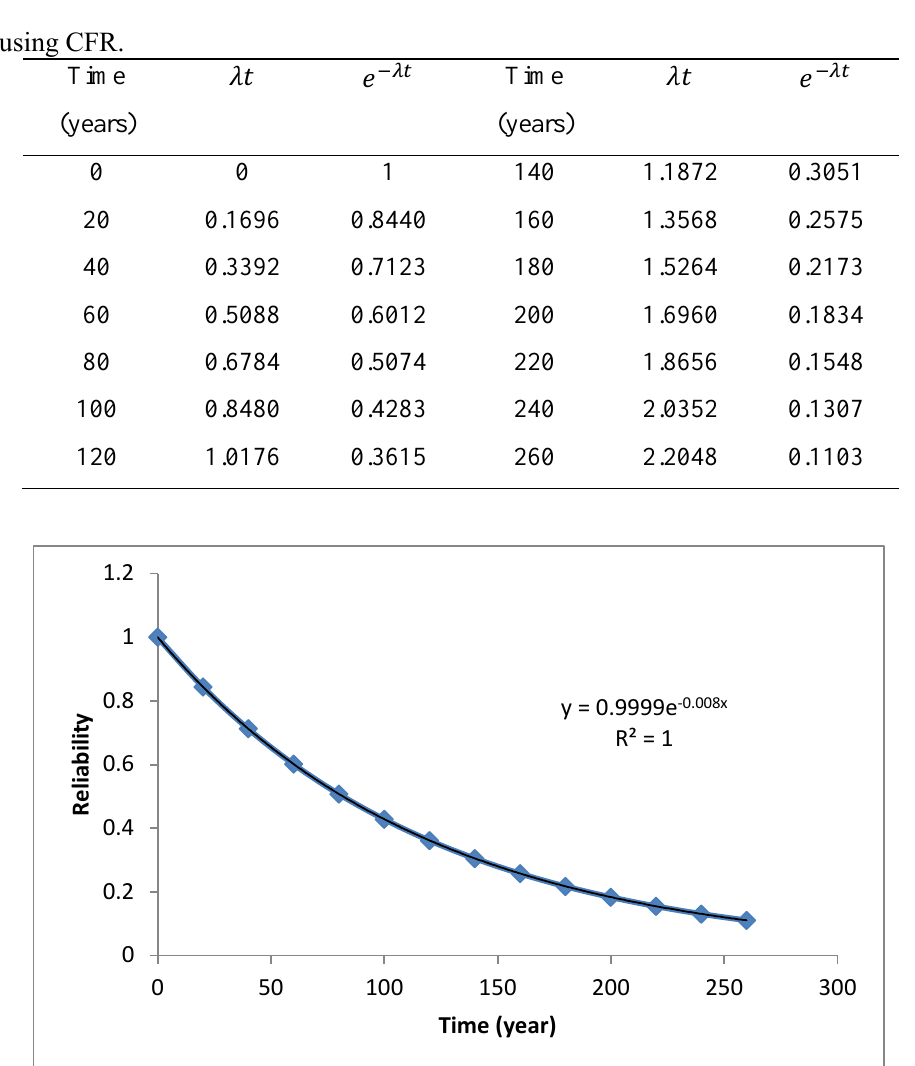
Fig. 7. Reliability of Mahogany